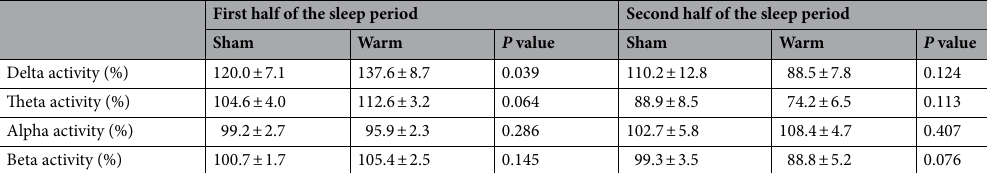
Table 4. Sleep EEG activity during the sleep phase. All values are expressed as means ± SEM of eighteen subjects. Comparisons were performed relative to the sham condition using the Wilcoxon signed rank test.